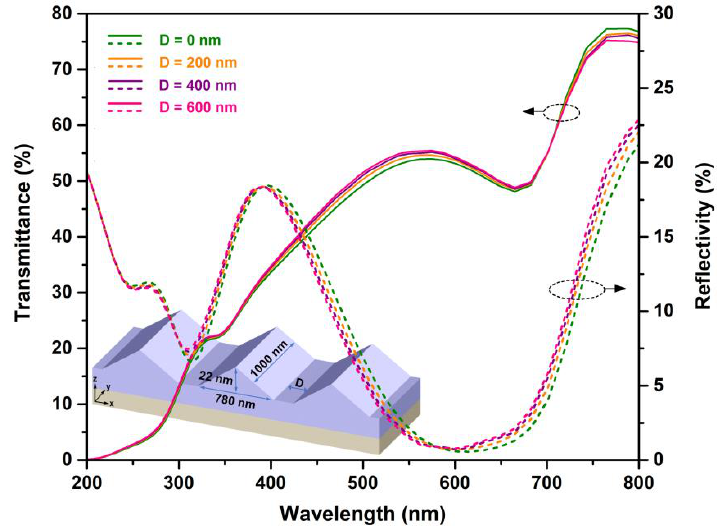
Figure 9. Transmission and reflection spectra of the textured surface with different spacings between adjacent SANR structures. The inset demonstrates the structural parameters of the numerical model: the width, height, and length of each ridge were fixed at 780, 22, and 1000 nm, respectively.